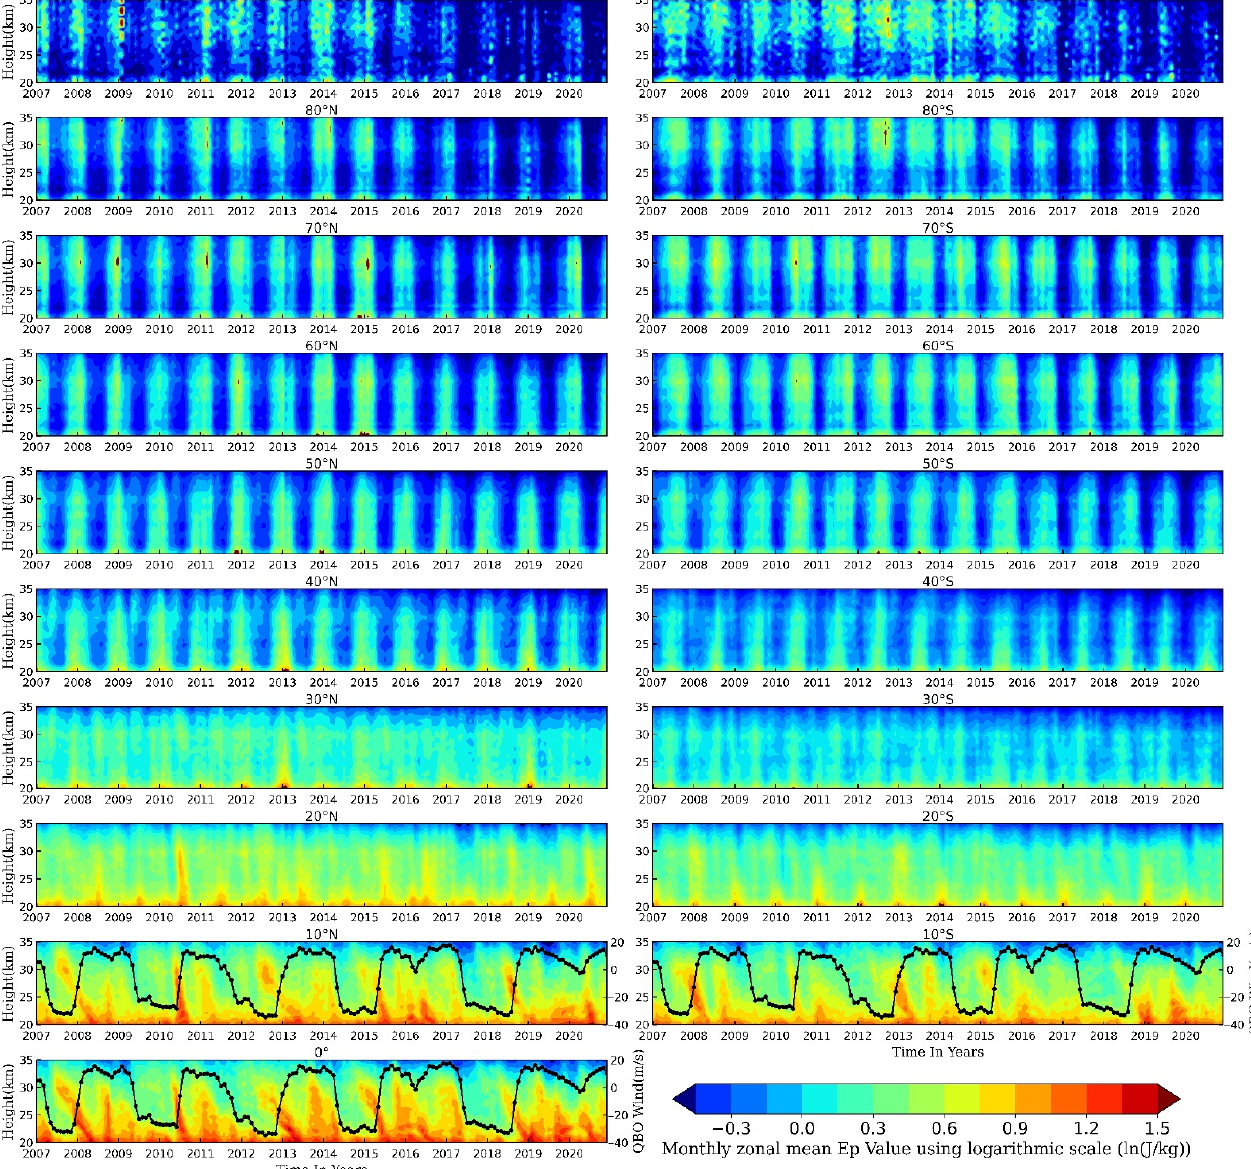
Figure 7. Time–height distributions of the monthly and zonal-mean GW Ep at 20–35 km over different latitude bands during 2007 to 2020. The unit of color bar is monthly and zonal-mean GW Ep using logarithmic scale (ln(J/kg)). The black dotted lines overlapped on the Ep distributions at 10° N/S and the equator present the QBO wind time series (label at the right y -axis).